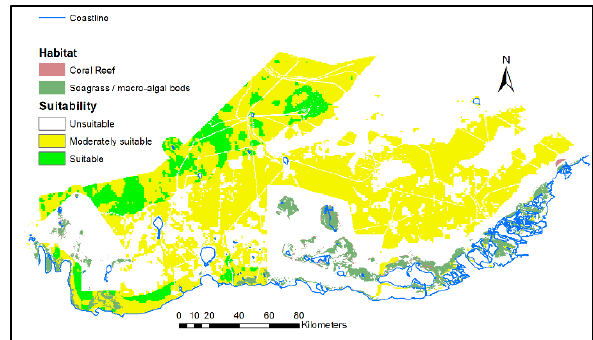
Figure 9: Suitability map and ecological